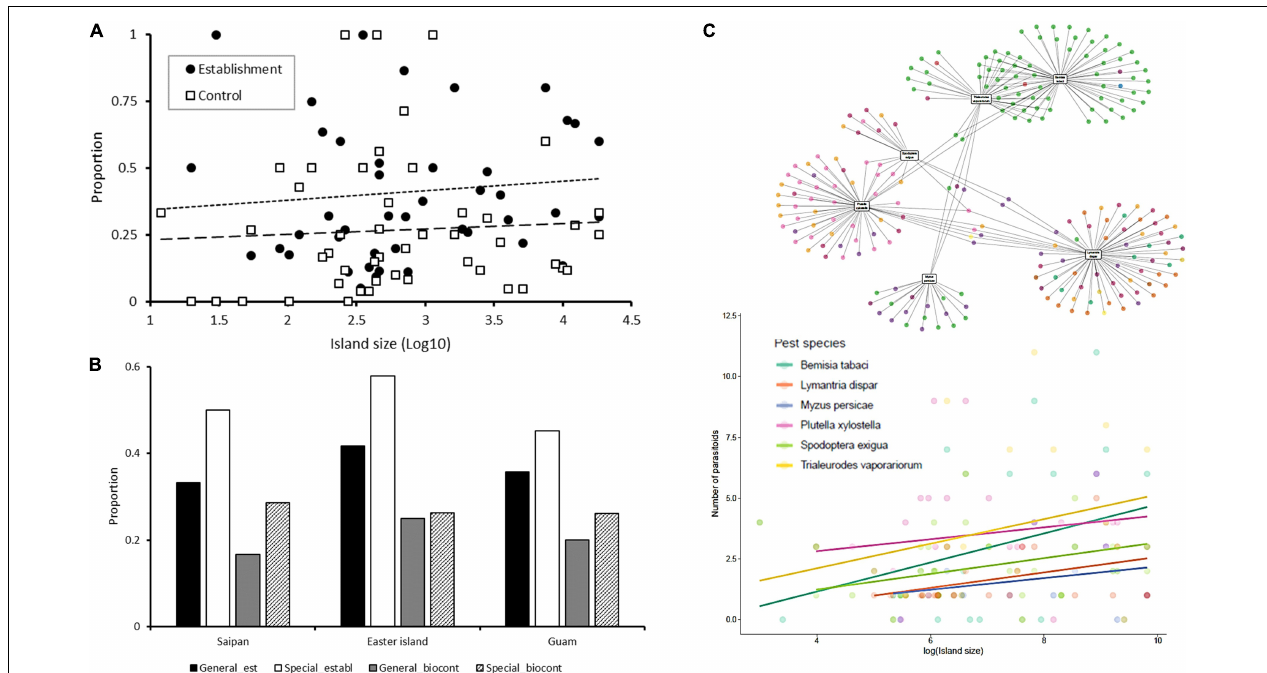
FIGURE 1 | Natural enemy establishment rates and the ensuing biological control outcomes on islands of different sizes. (A) Coarse-grained patterns show how neither insect biological control establishment [ F ( 1 , 47 ) = 0.300, p = 0.587] nor success rate [ F ( 1 , 47 ) = 0.882, p = 0.352] are affected by island size (12–18,280 km 2 range). Patterns are plotted for 49 islands harboring 14.9 ± 16.8 target insect pests and receiving 28.1 ± 34.3 insect BCAs (x ± SD). Islands and archipelagos are treated as comparable units (from Santos et al., 2010). (B) The proportion of generalist and specialist (i.e., parasitoids with less than 10 known hosts) BCAs that successfully established and provided (partial to good) control of target insect pests on Saipan (119 km 2 ), Easter Island (164 km 2 ), and Guam (549 km 2 ). (C) For six target herbivores, the number of parasitoids per herbivore host varies with island size (Santos et al., 2010). Parasitoid occurrence records are extracted from the GloBI interface for each island and target herbivore, and trophic linkages are plotted. Parasitoid families are represented by differently colored dots in the food web; trendlines are shown per target herbivore: B. tabaci ( p = 0.047, R 2 = 0.130), L. dispar ( p = 0.038, R 2 = 0.174), M. persicae ( p = 0.452), P. xylostella ( p = 0.441), S. exigua ( p = 0.036, R 2 = 0.164), T. vaporariorum ( p =